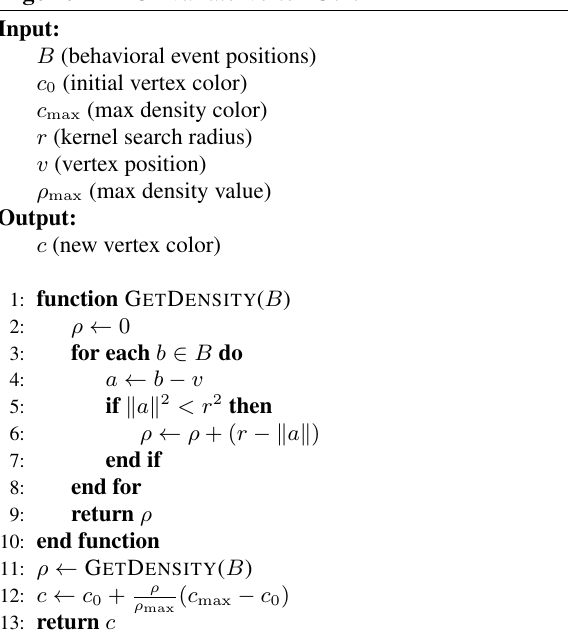
Algorithm 1 Univariate Vertex Color